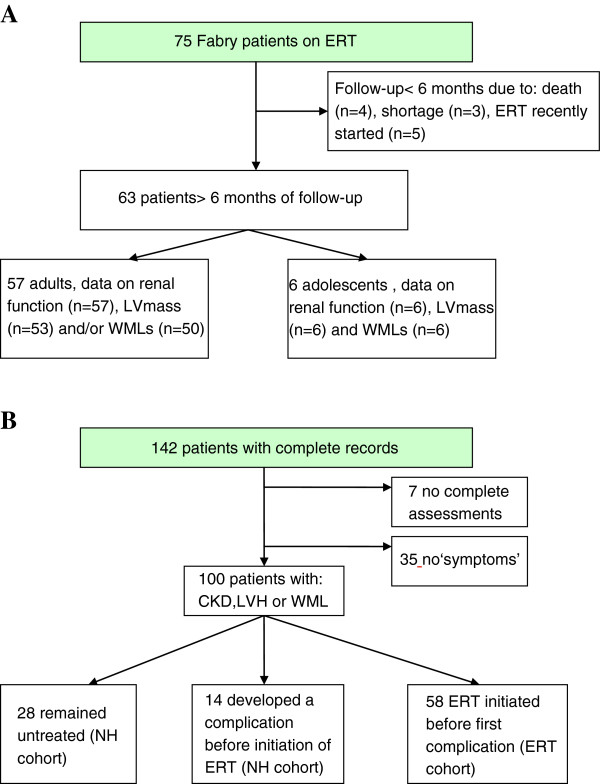
Overview of ERT and non-ERT cohort. A. The flow-chart shows the patients in the ERT cohort for the prospective analysis of renal function, left ventricular mass and cerebral white matter lesions; B. the flow-chart demonstrates all patients with complete medical records and the cohorts used for the analysis of the age to the first complication.